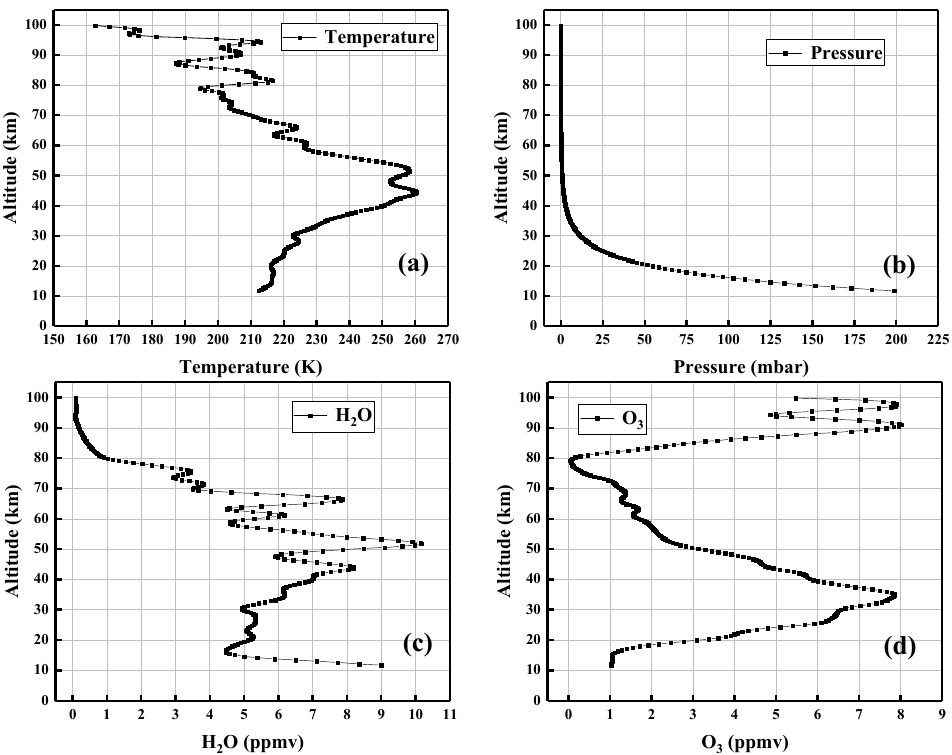
Figure 3. Atmospheric profiles of ( a ) temperature, ( b ) pressure, ( c ) H 2 O mixing ratio, and ( d ) O 3 mixing ratio from TIMED/SABER on Xi’an (Shaanxi, China, 20 March 2022).